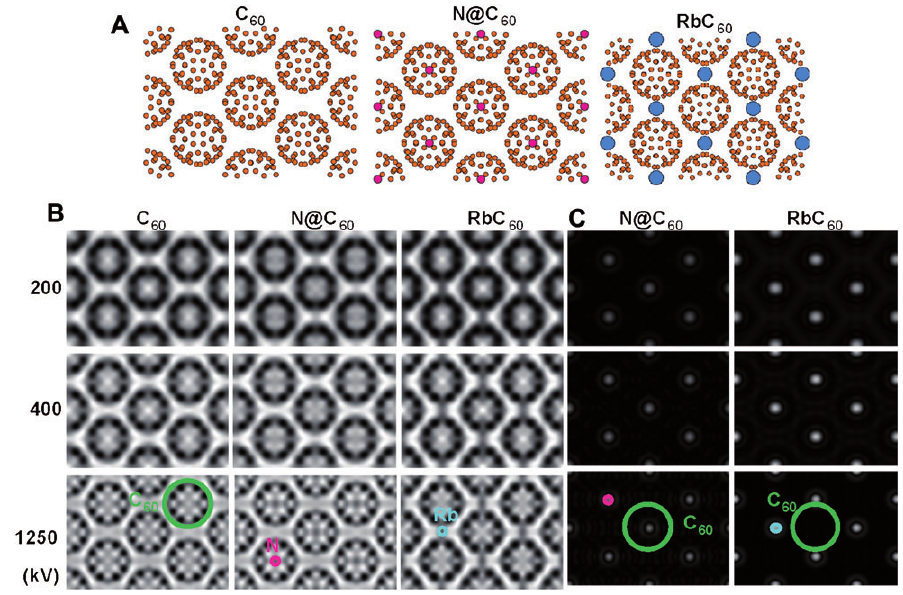
Figure 13 (A) Structure models of C , N@C , and RbC solid clusters projected along the [100] directions of the orthorhombic cell. (B) 60 60 60 , N@C , and RbC calculated along the [100] direction of the orthorhombic cell as a function of accelerating voltage of HREM images of C 60 60 60 electron microscopes. The crystal thickness is two slices. (C) Difference images of C tion as a function of accelerating voltage. Image depth of 0 – 63 gray